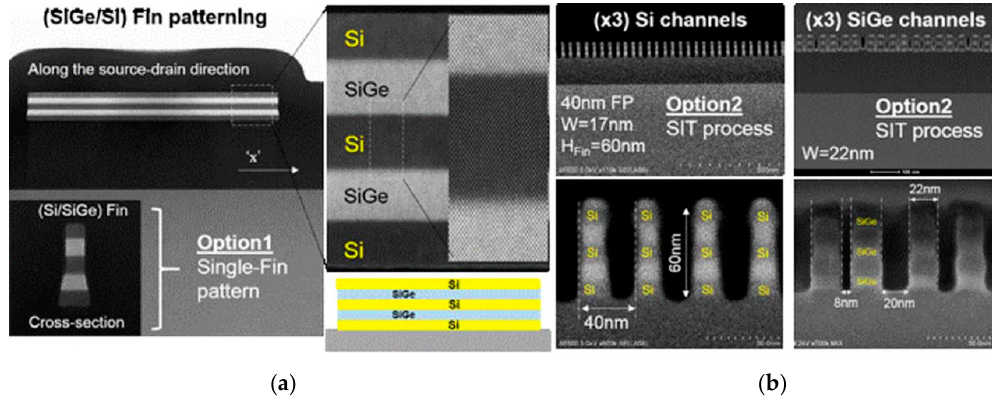
Figure 24. TEM images of post-etching of Si/SiGe multilayer fins in two directions (longitudinal and transverse cross-section). Two fin-patterning options have been designed: ( a ) Isolated and ( b ) dense FETs, which were carried out by sidewall pattern transfer technology [112].